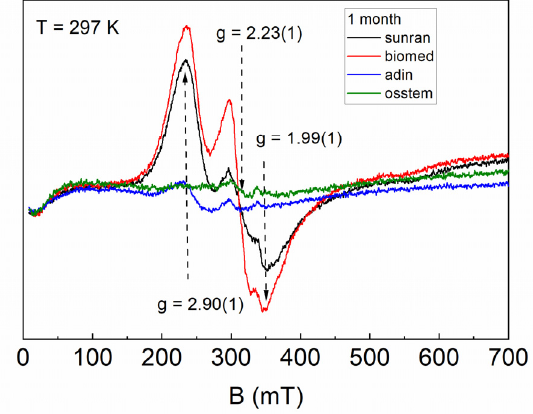
Figure 2. EPR spectra of bone tissue samples before irradiation depending on the implantation sys- tem after one month of installation.